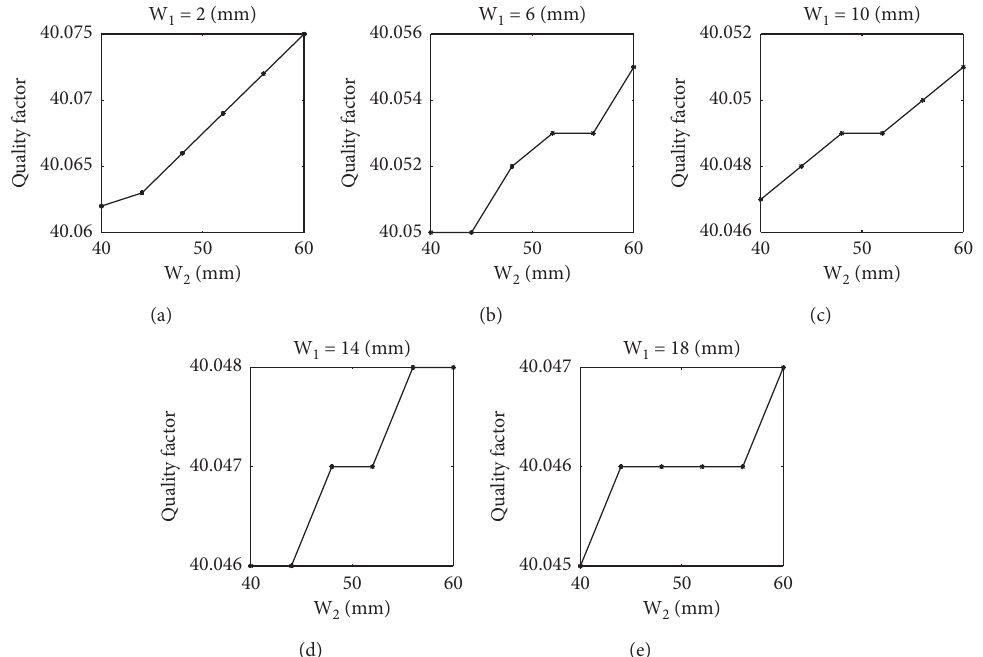
Figure 3: The quality factor of the second trapezoidal bimorph design. The structure loss factor is 0.025. The damping ratio is 0.017. The length of the beam L is 60mm, the thickness of T piezo is 0.3mm, and the thickness of the brass layer T s is